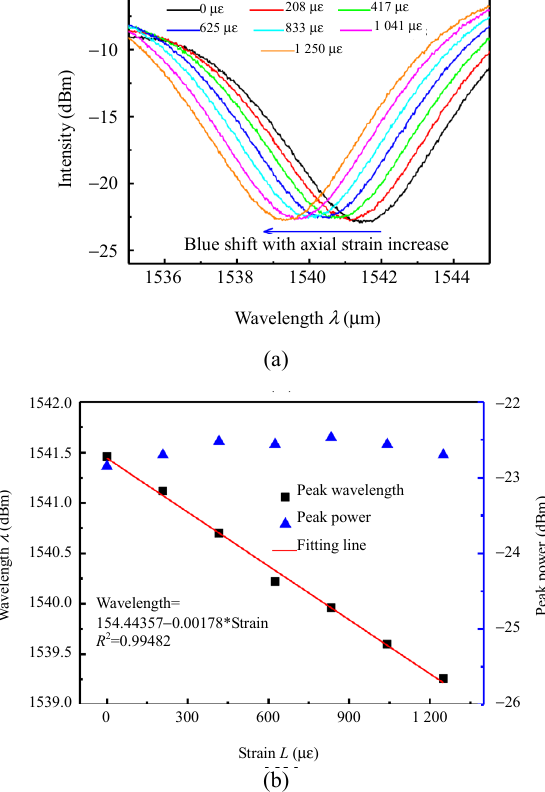
Fig. 8 Experimental results: (a) wavelength blue shift depending on micro-strain increase and (b) the curve of the micro-strain vs. wavelength (solid line) and variation of peak power during the measurement (dotted